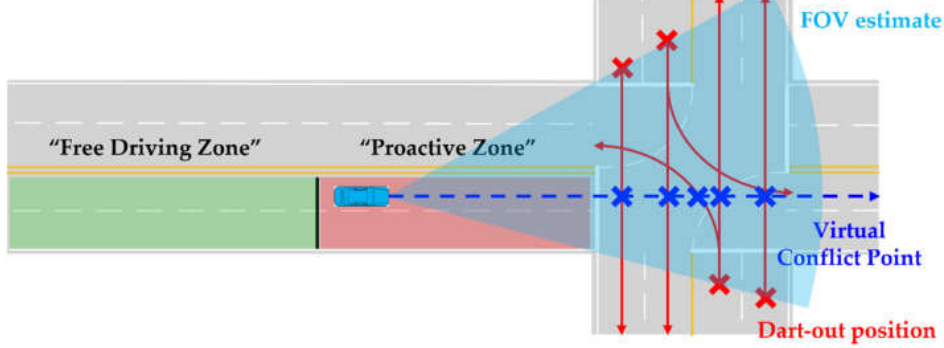
Figure 4. Virtual conflict point decisions for intersection driving.